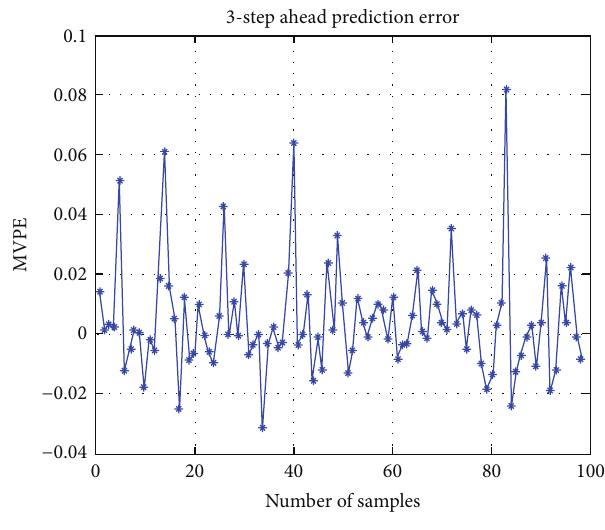
Figure 8: Values of